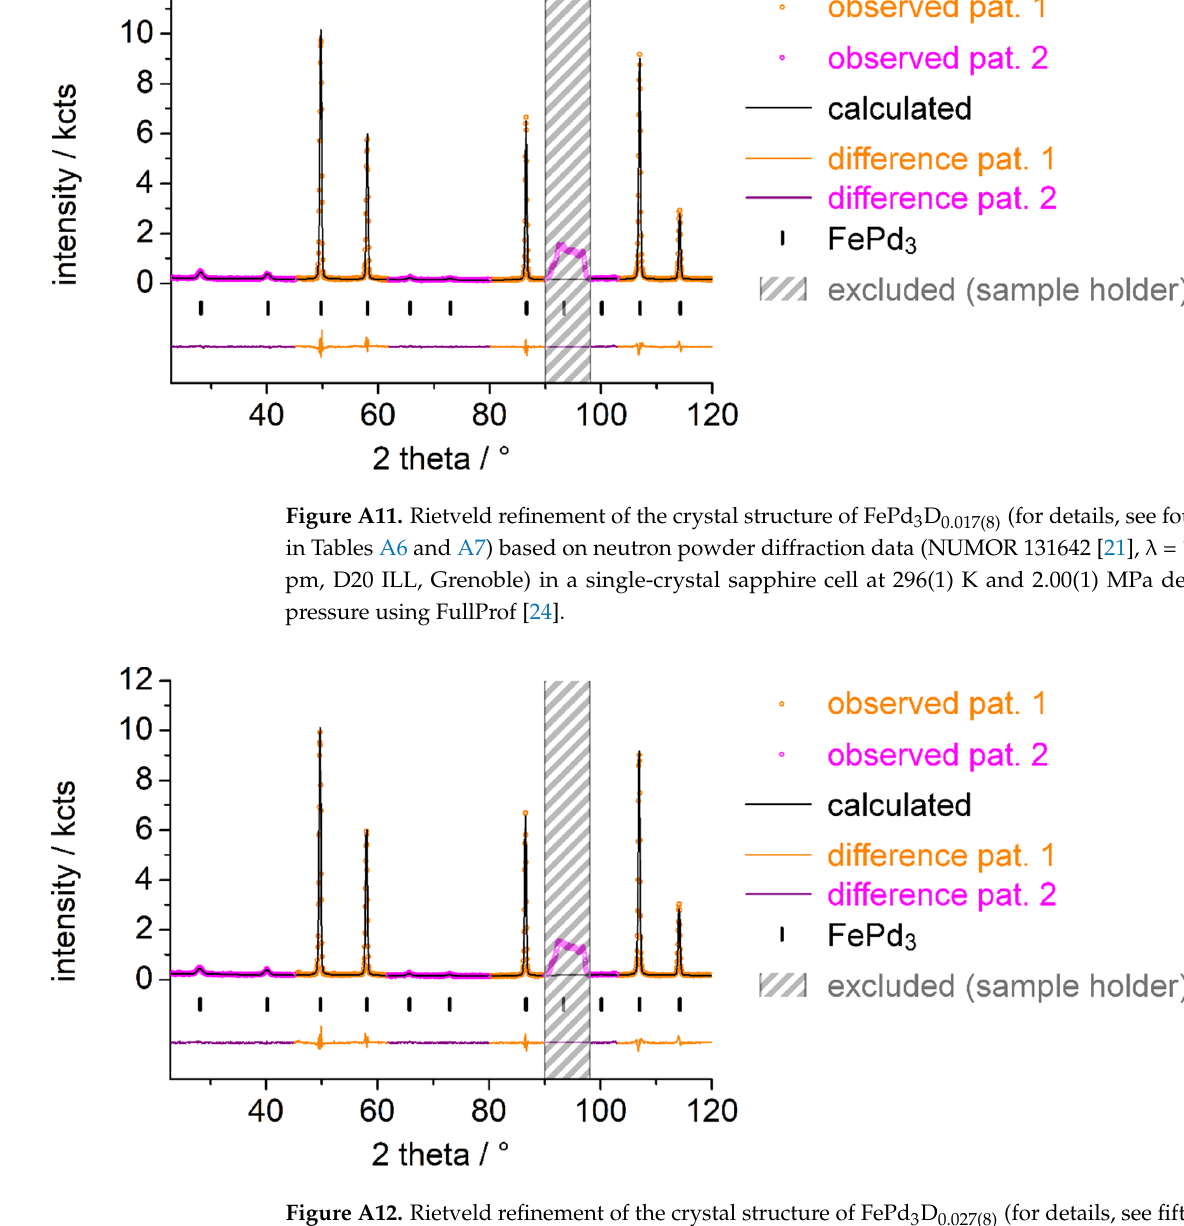
Figure A10. Rietveld refinement of the crystal structure of FePd 3 D 0.015(8) (for details, see third row in Tables A6, A7) based on neutron powder diffraction data (NUMOR 131634 [21], λ =186.80(2) pm, D20 ILL, Grenoble) in a single-crystal sapphire cell at 296(1) K and 1.00(1 ) MPa deuterium pres- sure using FullProf [24].